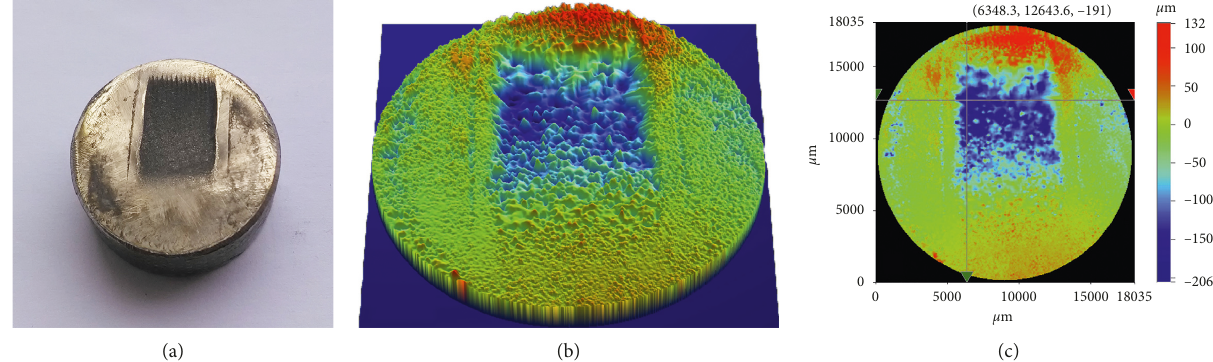
Figure 10: Optical image of Sample No. 2 after IATD test (a); OSP perspective micrograph (b); OSP height map micrograph (c).